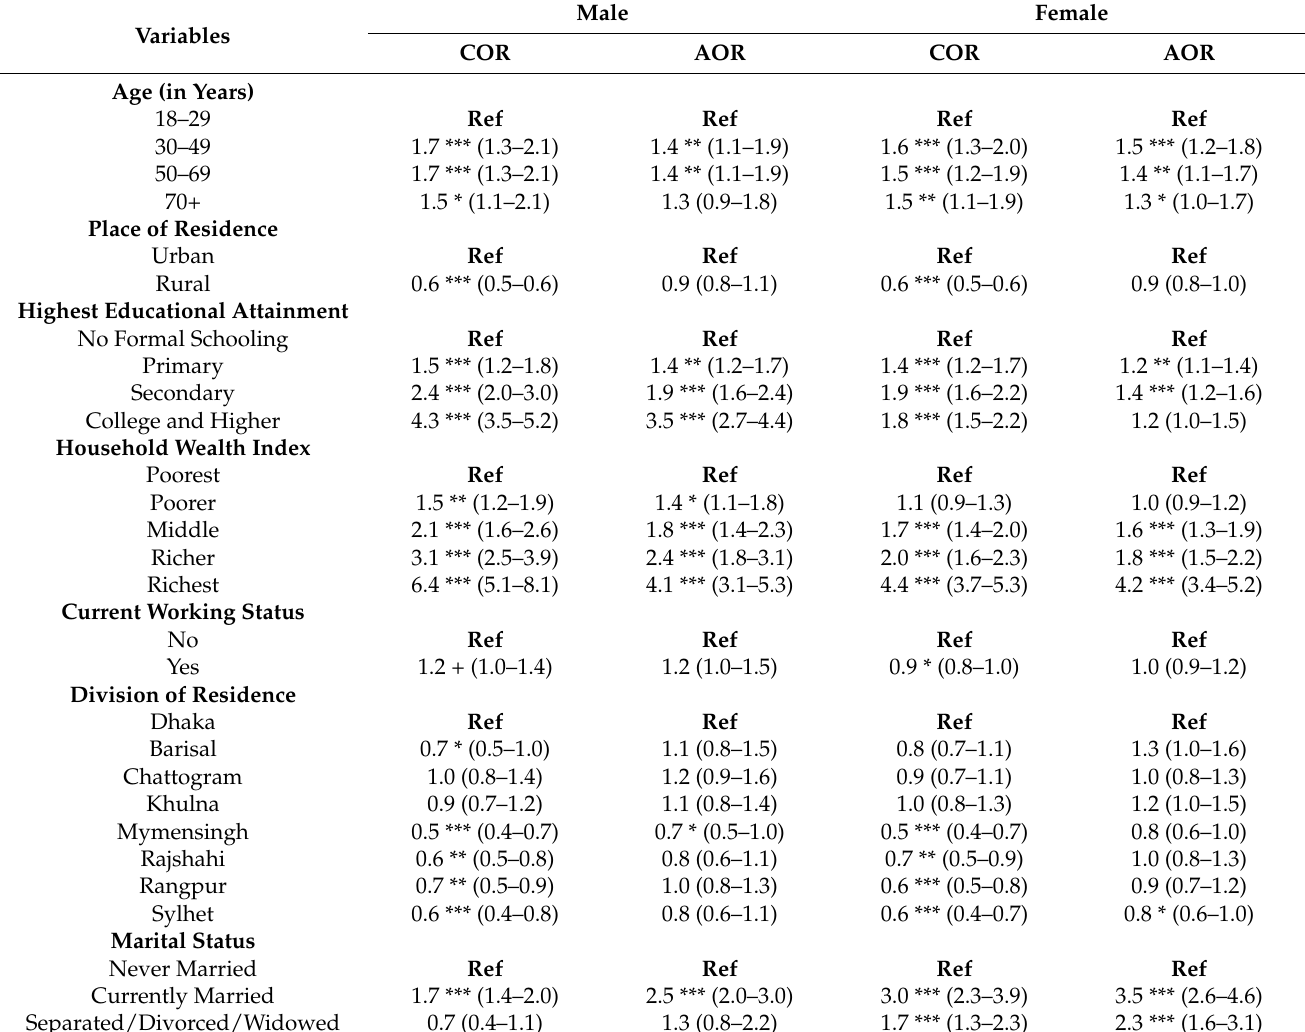
Table 3. Factors associated with overweight/obesity among both male and female, BDHS